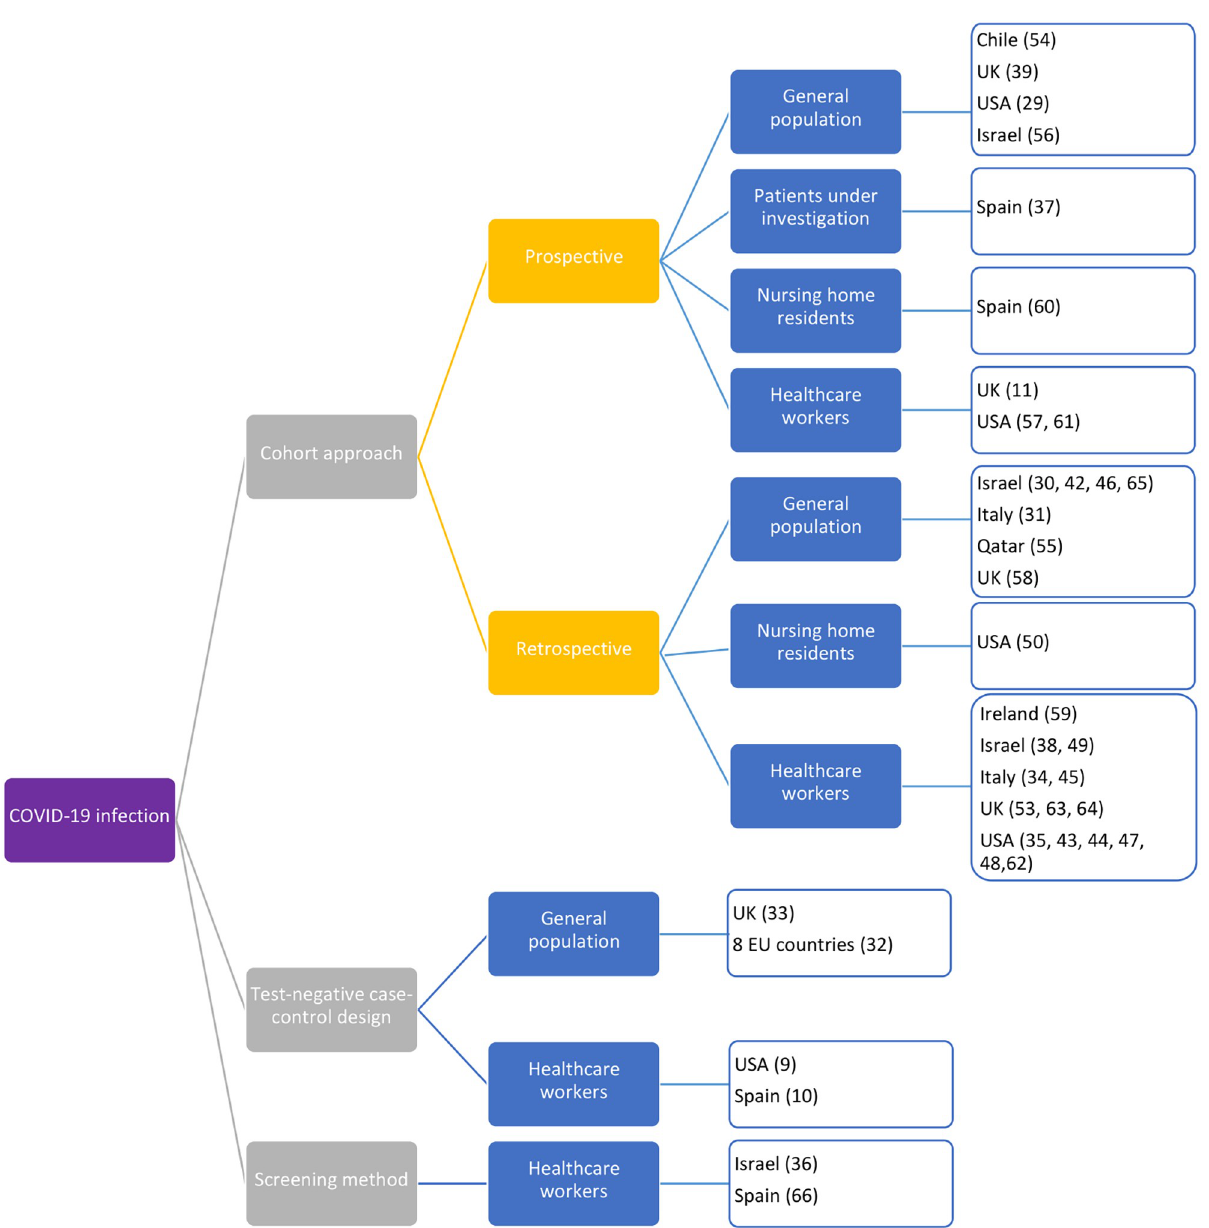
Fig 2. Study design by outcome for COVID-19 vaccine effectiveness studies meeting inclusion criteria.